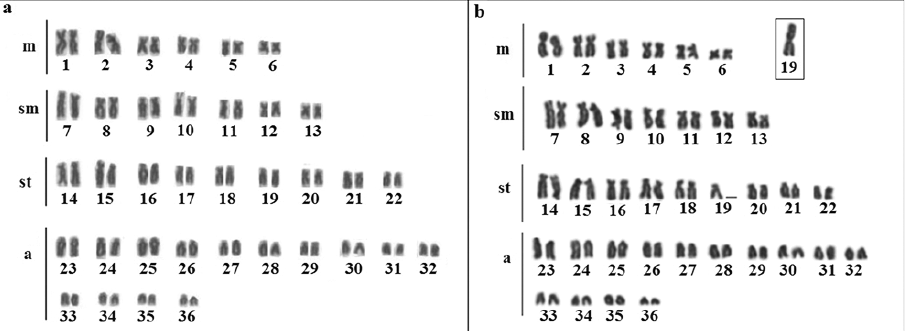
Figure 1. Giemsa stained karyotypes of Hypostomus regani : a karyomorph A b karyomorph B. Scale bar: 10µm.